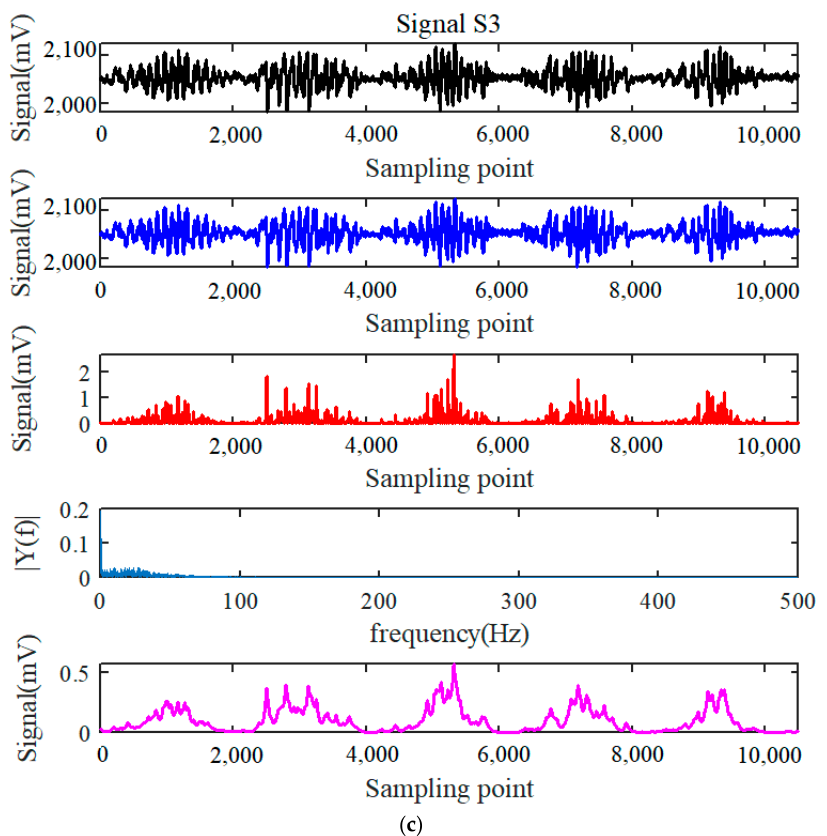
Figure 8. Different weak signals processed by HHT and lowpass filtering method. ( a ) HHT and lowpass filtering method for wire rope signal S1; ( b ) HHT and lowpass filtering method for wire rope signal S2; ( c ) HHT and lowpass filtering method for wire rope signal S3.